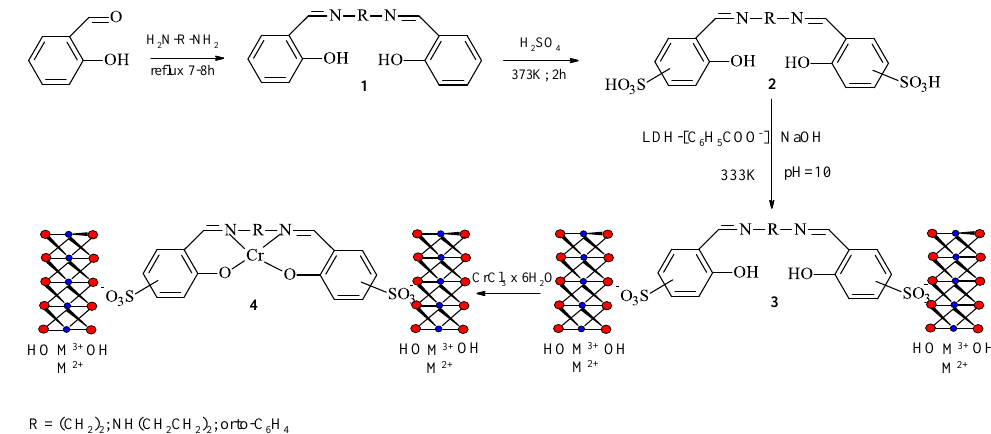
Figure 6. The synthesis of MgAl-LDH with intercalated [Cr III (SO 3 -salen)] 2 − . Adapted from Ref. [28], Copyright 2007, Elsevier.